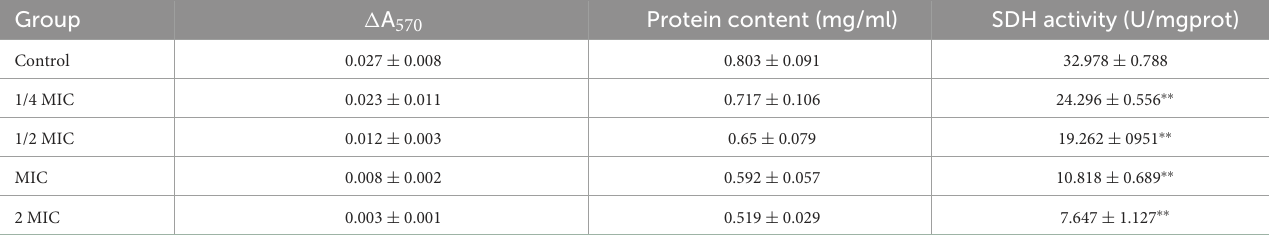
TABLE 5 Effect on SDH of bacteria treated with SEDQS.